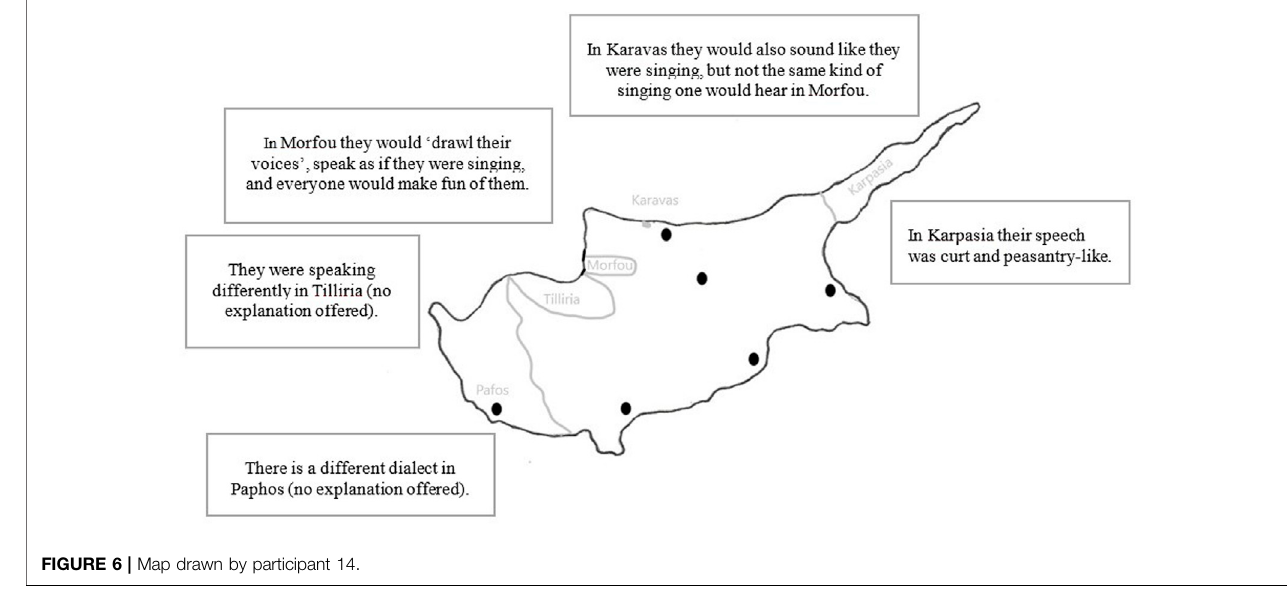
FIGURE 6 | Map drawn by participant 14.